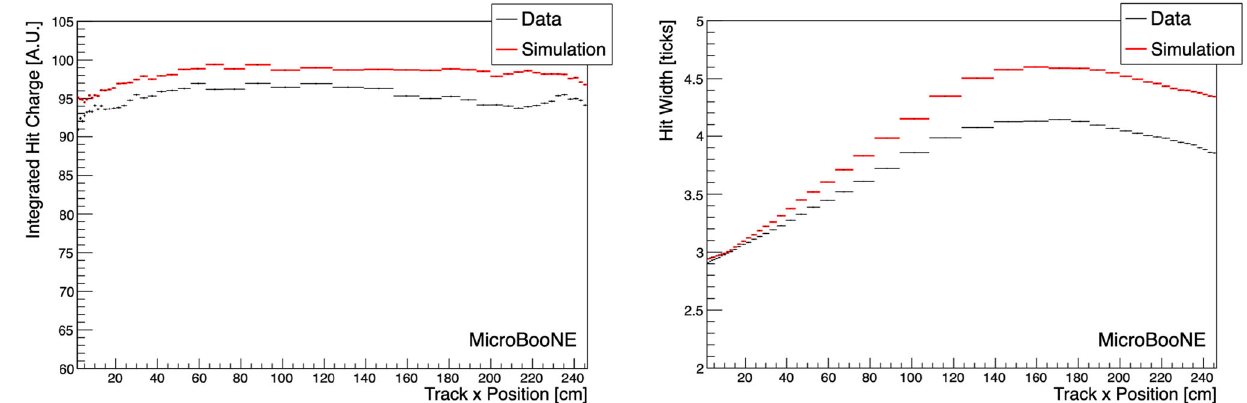
Fig. 4 Hit charge and hit width vs. x in data and simulation (MC) for the collection plane. The values are computed from histograms similar to the example shown in Fig. 3 using the algorithm based on the iterative truncated mean described in the text